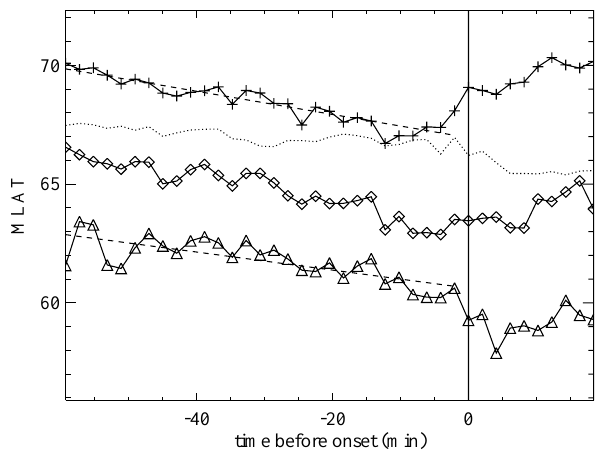
Fig. 7. Evolution of the equatorial (triangles) and polar (pluses) boundaries in the one-hour wide sector around midnight during the same event as before. The diamonds represent the maximum of the proton precipitation, and the dotted line is the value of the calculated IB for the solar wind conditions and D st